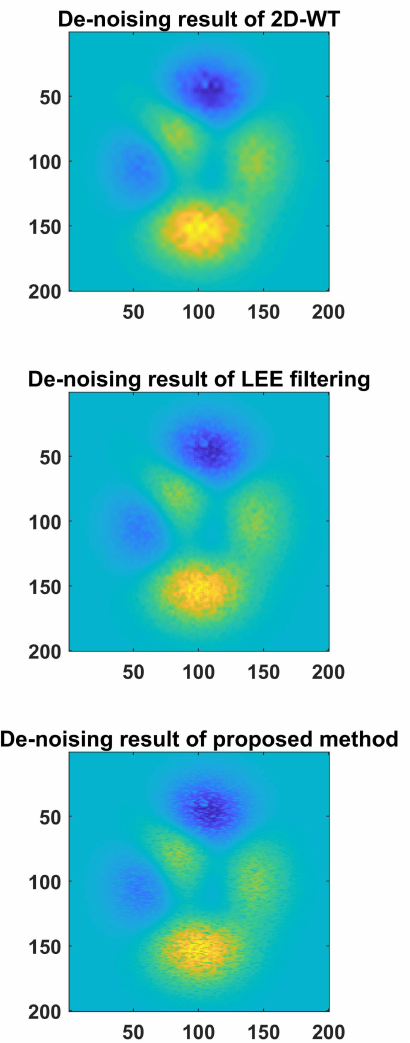
Figure 4. De-noising results acquired from various methods.